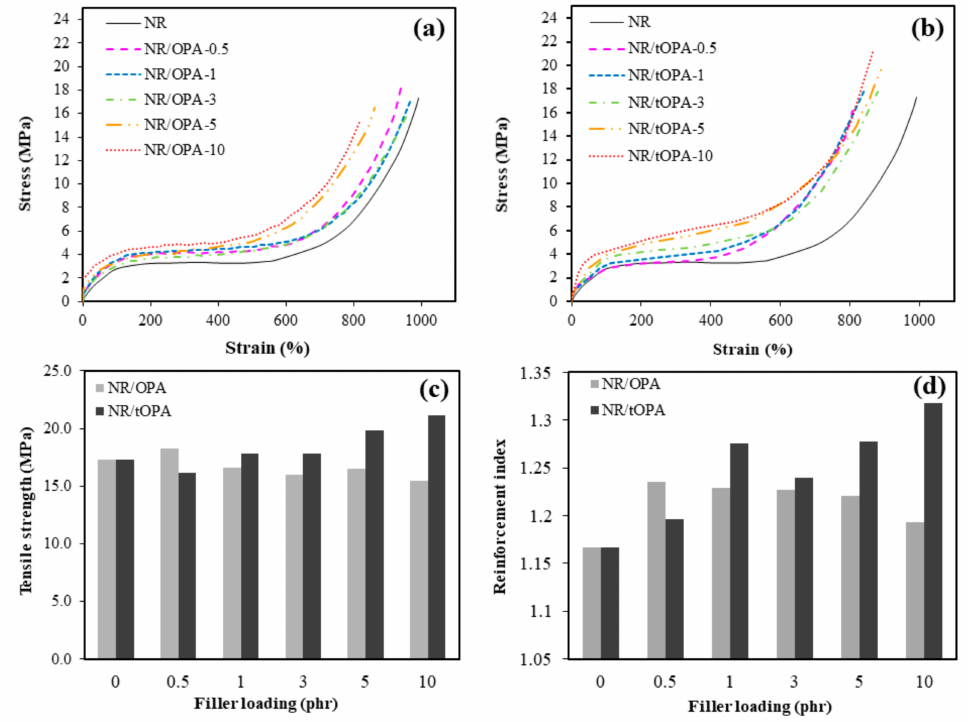
Figure 12. Stress-strain curves of ( a ) NR/OPA and ( b ) NR/tOPA; ( c ) tensile strength and ( d ) rein- forcement index of NR/OPA and NR/tOPA at various filler